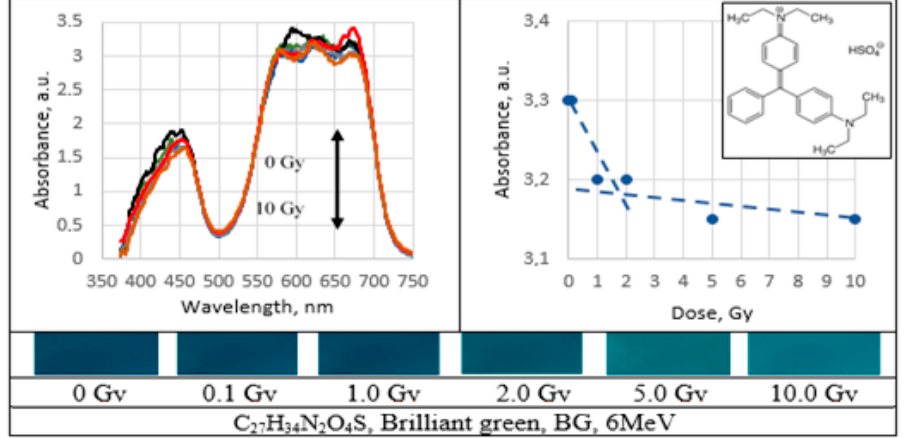
Figure 7. Absorbance spectra and sensitivity of the irradiated brilliant blue films.